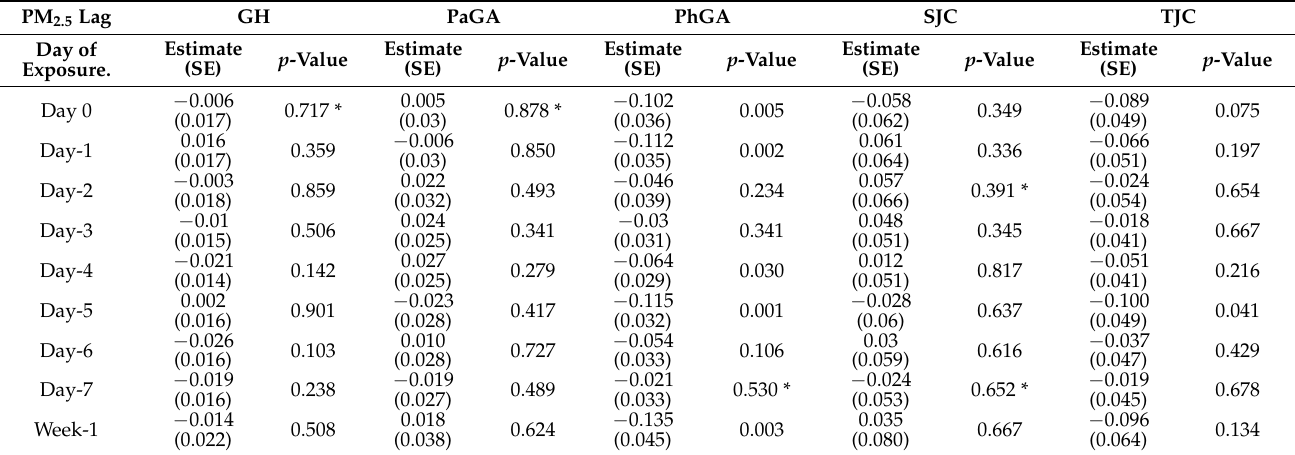
Table A5. Associations between PM 2.5 short-term exposure and RA disease activity.